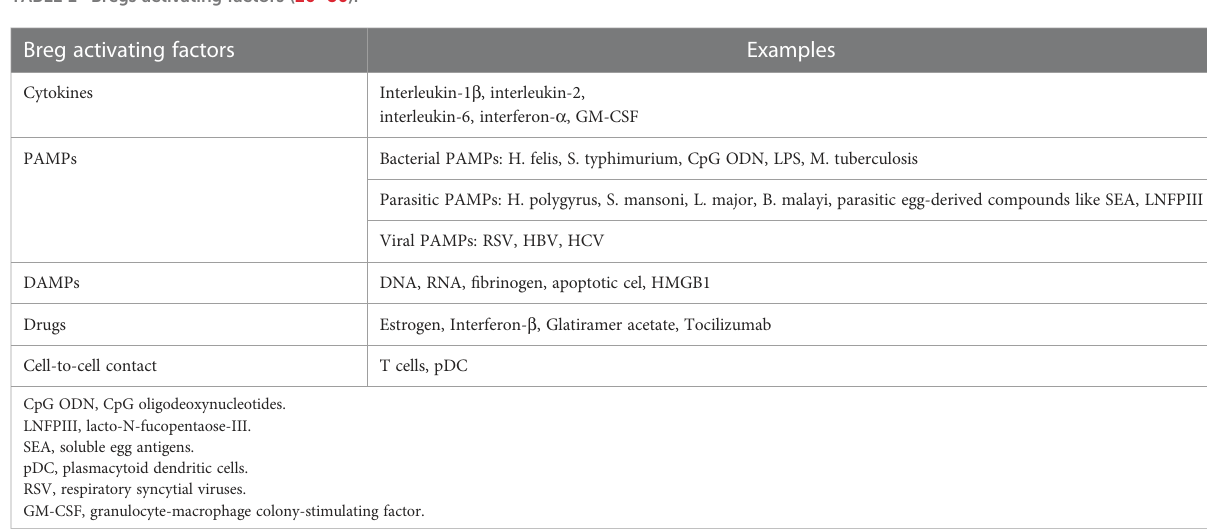
TABLE 1 Bregs activating factors (26 – 30).